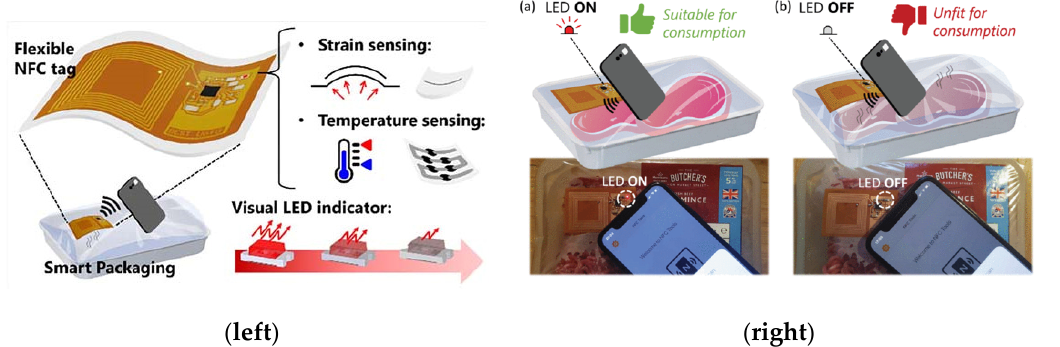
Figure 6. Smart tag with a near-field communication (NFC)-based sensing system to identify a dynamic strain or temperature visually semi-quantitatively: ( left ) the tag consists of a sensor (a microchannel-based sensor or a printed temperature sensor) and a LED as an indicator; ( right ) use of the sensor on a food package for meat spoilage determination causing blown pack spoilage. Figure by Pablo Escobedo et al. from [89], licensed under CC BY 4.0.